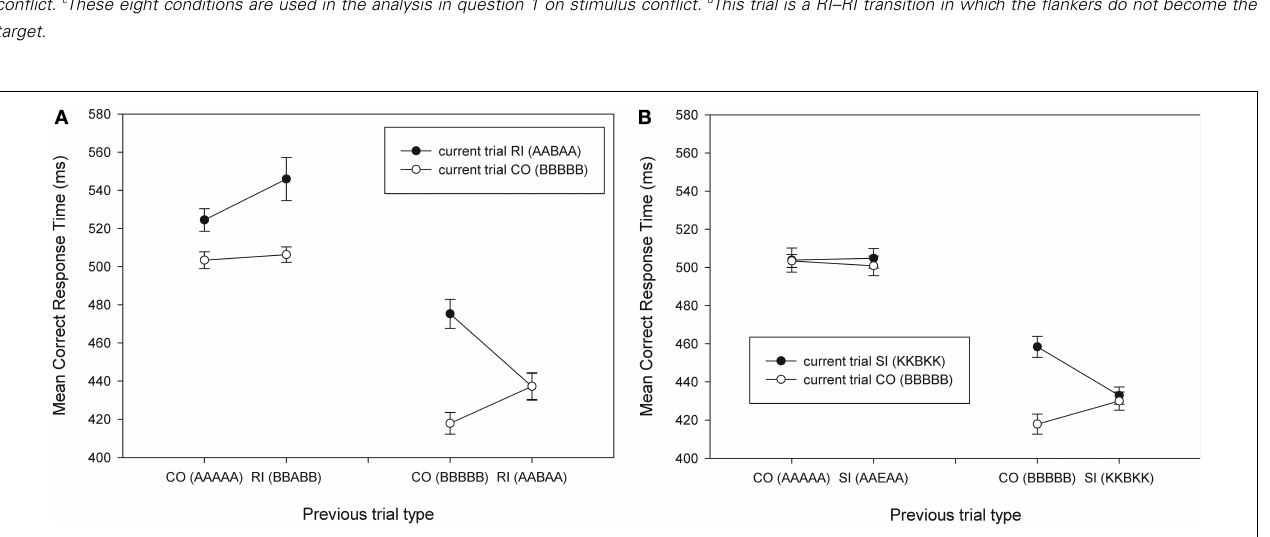
FIGURE 3 | Mean correct RTs as a function of current trial type and previous trial type . (A) CO/RI combinations that include response conflict. (B) CO/SI combinations that include only stimulus conflict. Examples of previous and current trials are presented in brackets. CO, congruent; SI, stimulus- incongruent; RI,